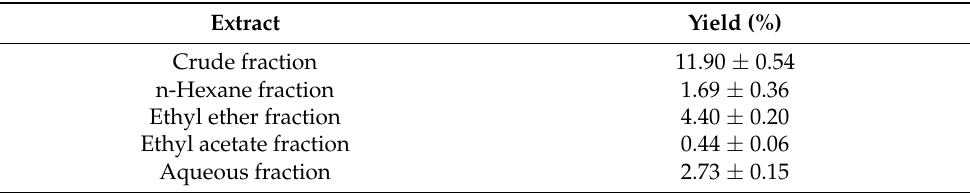
Table 1. The yield of different liquid-liquid separation.